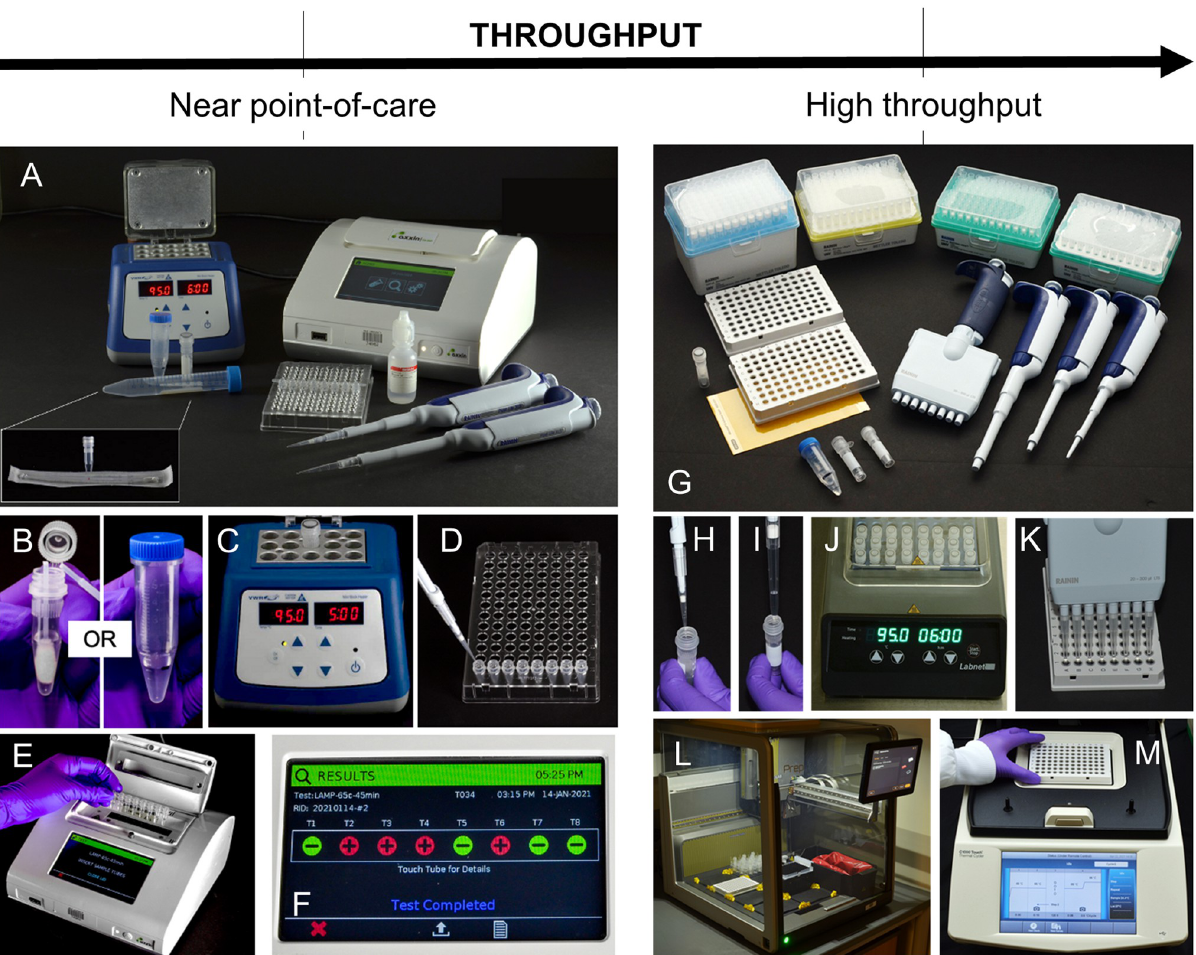
Fig 1. Near point-of-care and high-throughput sample-to-answer workflows. (A-F) Near point-of-care workflow. (A) Equipment and consumables needed to run the RT-LAMP assay, including saliva collection and lysis tubes, a heat block, pipettes, mineral oil, and a benchtop fluorimeter. A nasal swab and lysis tube (inset) can be substituted for saliva collection materials. To perform the test, (B) either a nasal swab or saliva sample is collected and combined with lysis buffer, then (C) the sample is heated at 95˚ C for 5 (nasal) or 6 (saliva) minutes. (D) The lysed sample is then added to RT-LAMP reagents and (E) reactions are sealed and placed in a benchtop fluorimeter and heated at 65˚ C for 45 minutes with real-time fluorescence monitoring. (F) Results are displayed after the full incubation period. (G-M) High-throughput saliva workflow. (G) Consumables and pipettes needed to run the RT-LAMP assay, excluding Hamilton robotics consumables. To perform the test, (H) lysis buffer and (I) saliva are combined and (J) heated at 95˚ C for 6 minutes. (K) RT-LAMP master mix is prepared and added to a 96-well plate. (L) Inactivated samples are added to RT-LAMP master mix by a Hamilton MicroLab Prep. The plate is sealed and (M) placed onto the Bio-Rad CFX96 for amplification and detection. Results are analyzed within the Bio-Rad Maestro